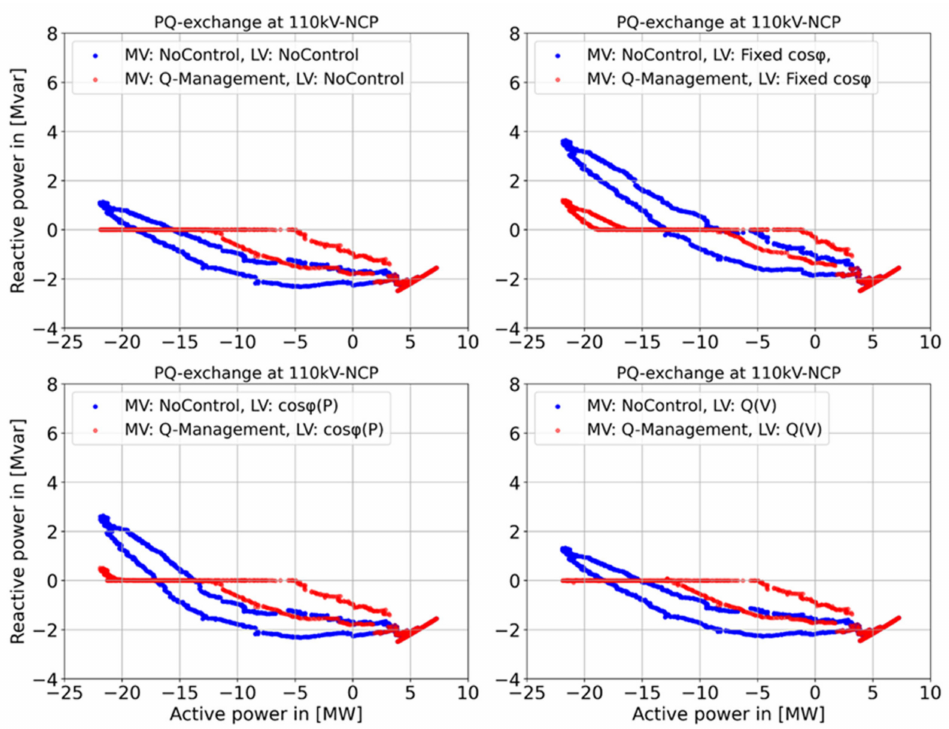
Figure 13. Daily simulated P and Q exchange at 110 kV-NCP using the proposed Q management at the MV level and different local voltage control strategies at the LV